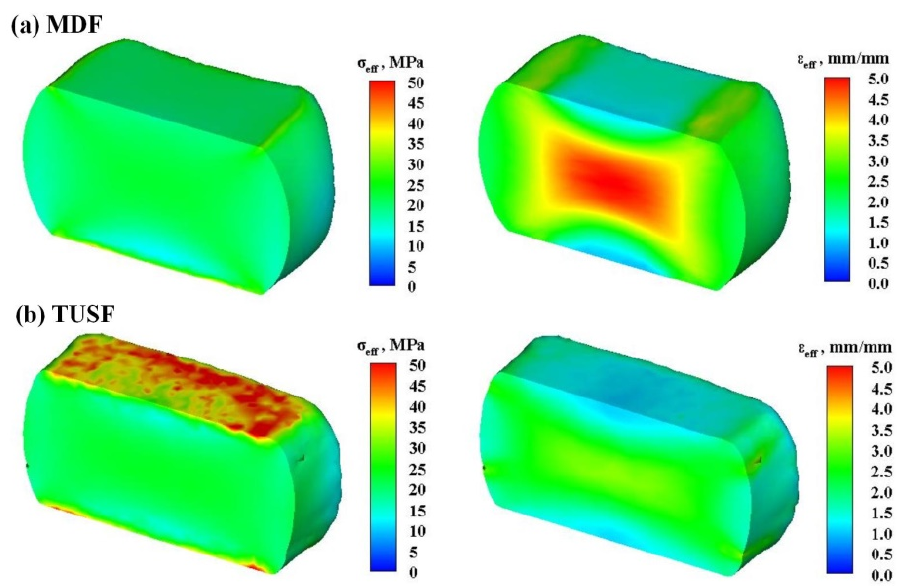
Figure 15. Effective stress and strain distributions in ( a ) MDF and ( b ) TUSF specimens.